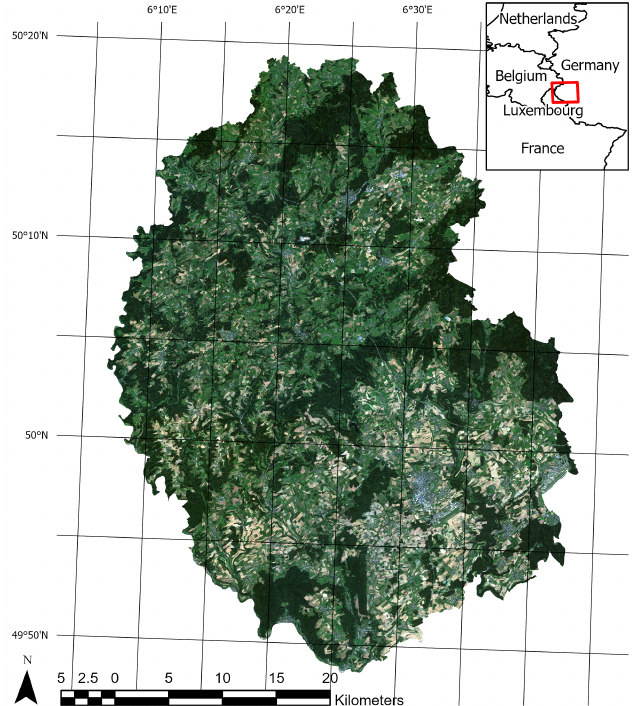
Figure 1. The figure shows an overview of the study area. The background shows a RapidEye true color composite from